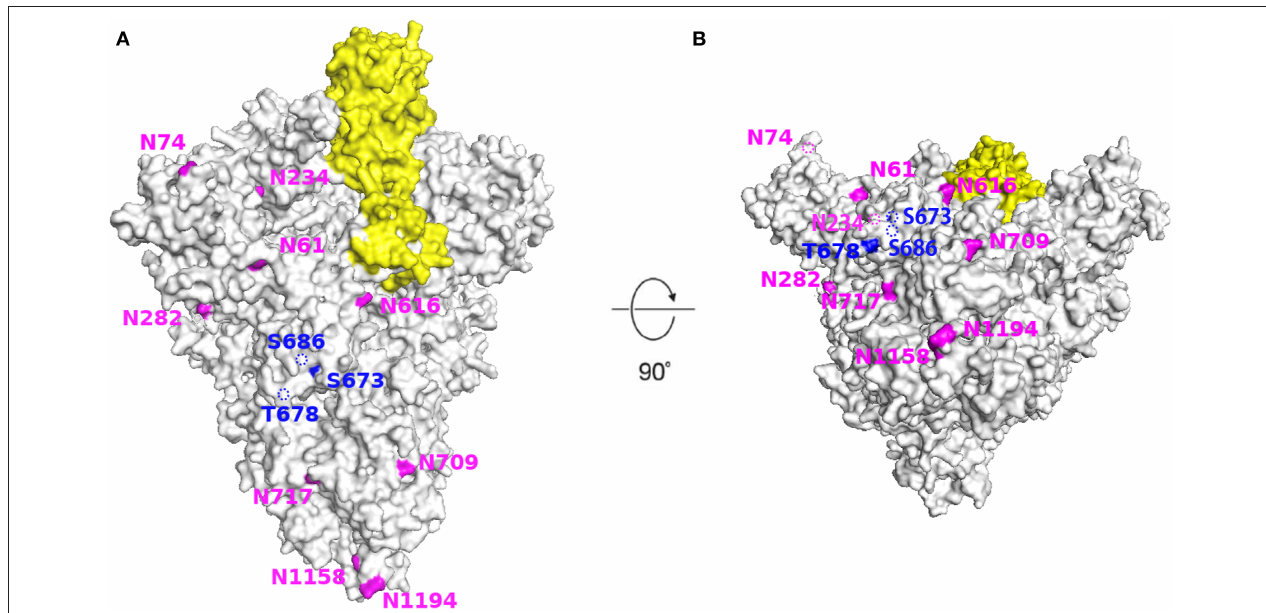
FIGURE 7 | Structural modeling of SARS-CoV-2 spike protein showing the location of all glycosylation sites. The SARS-CoV-2S protein (light gray) with receptor binding domain (yellow) and N-(amaranth) and O- (dark blue) glycosylation sites. (A) Side view. (B) Bottom view. Images generated using PyMol (version 2.3.4) based on the 3D structure (PDB ID: 6VSB). The dotted line indicates that the site is located inside the